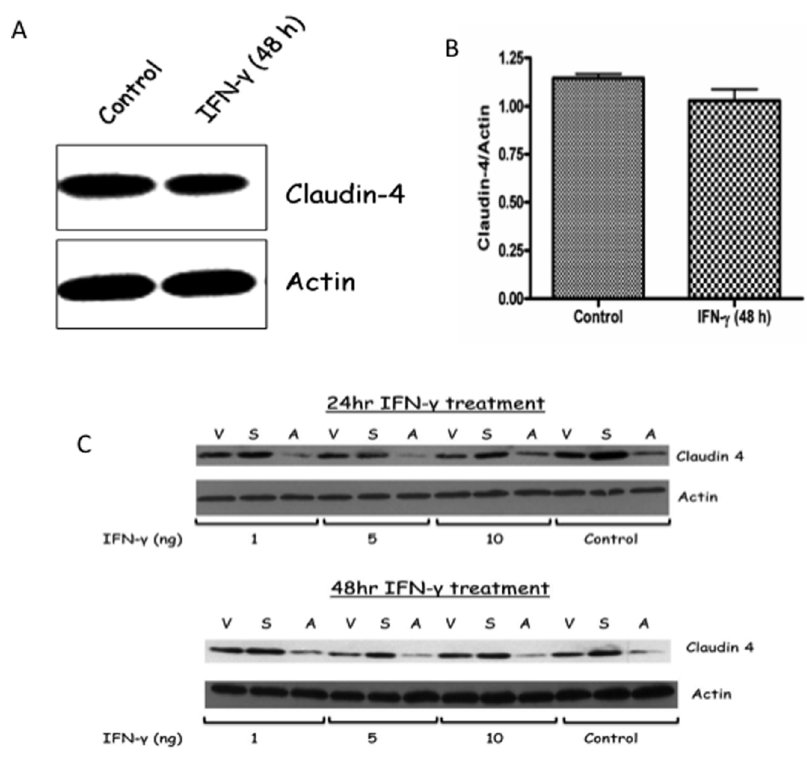
Figure 7. Stimulation of Caco-2 cells with IFN- c decreases claudin-4 expression. (A) Caco-2 cells grown to confluence on regular culture plates were stimulated with 5 ng/ml of IFN- c for 48 h. At the end of stimulation, cells were analyzed for claudin-4 expression by western blotting. (B) The corresponding densitometry analysis for claudin-4 expression. (C) Western blots depicting dose and time response of IFN- c treatment on claudin- 4 expression in vector control, EP2S and EP2A cells. Three different doses of IFN- c (1, 5 and 10 ng) exposed for 24 and 48 h time period were studied and compared with corresponding untreated control cells. V=vector control; S=EP2S; A=EP2A.